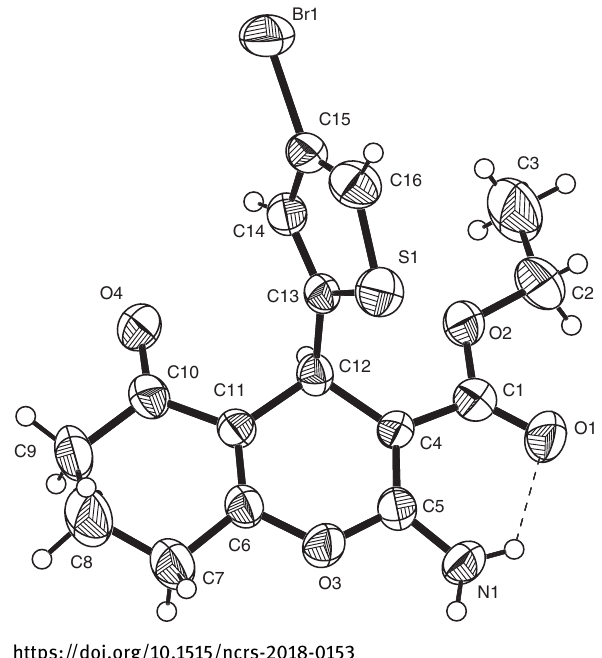
Table 1: Data collection and handling.